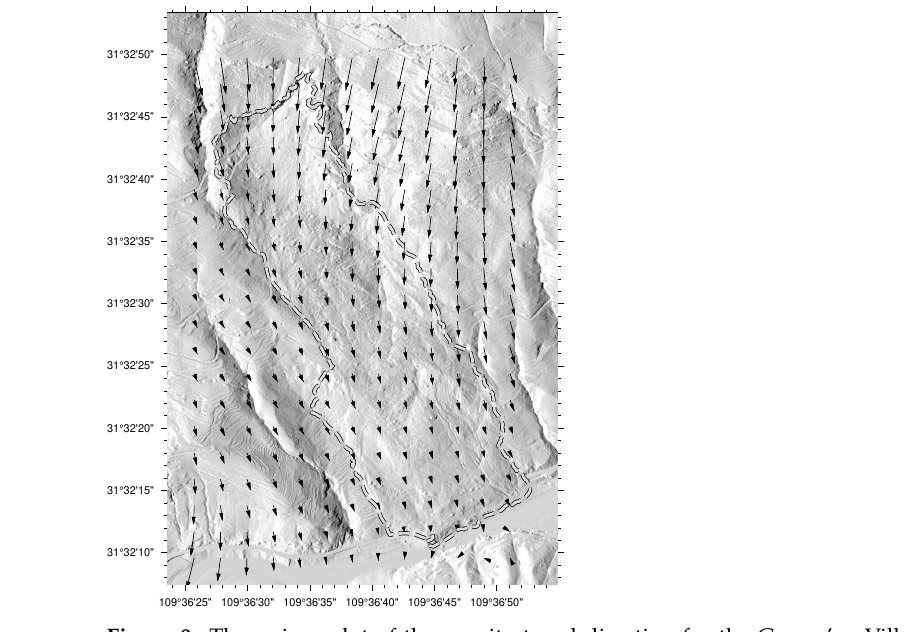
Figure 9. The quiver plot of the gravity trend direction for the Guang’an Village Landslide and